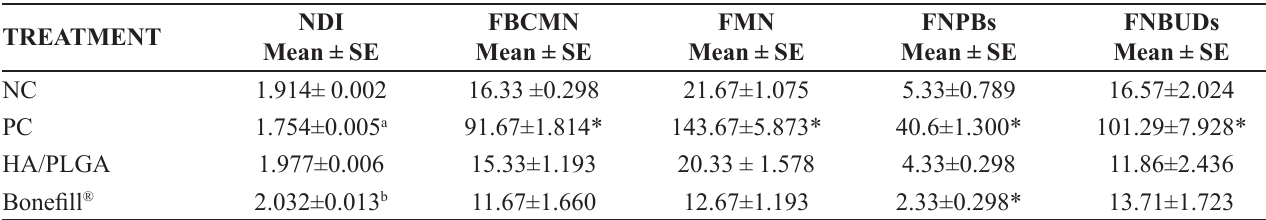
TABLE I - CBMN assay in CHO-K1. Mean and standard error of nuclear division index (NDI), frequency of binucleated cells with micronucleus (FBCMN), frequency of micronuclei (FMN), frequency of nucleoplasmic bridges (FNPBs) and frequency of nuclear buds (NBUDs), in 1000 binucleated cell for each treatment. Cells treated with 100% concentration of HA/PLGA and Boneffil ® eluates. NC: negative control; PC: positive control; *p<0.05 compared to NC group (Dunnett’s test); a,b = p<0.05 (Kruskal-Wallis’s test).